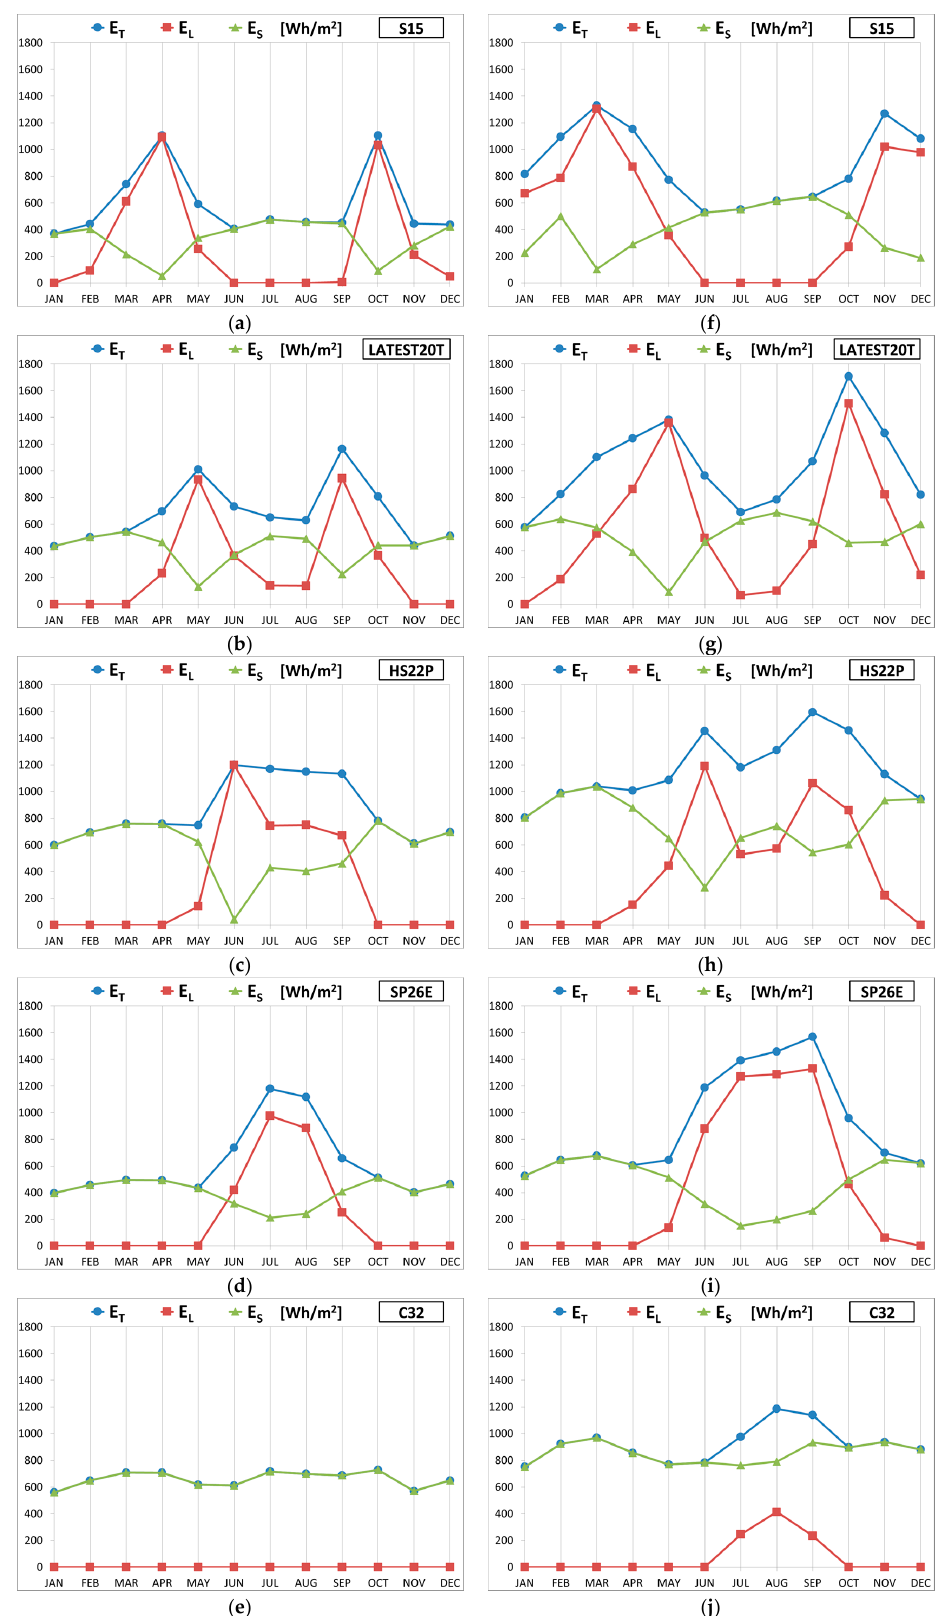
Figure 4. Monthly average daily total E T , latent E L and sensible E S energy stored in the different months for each type of PCM considered; Turin on the left ( a – e ) and Cosenza on the right ( f – j